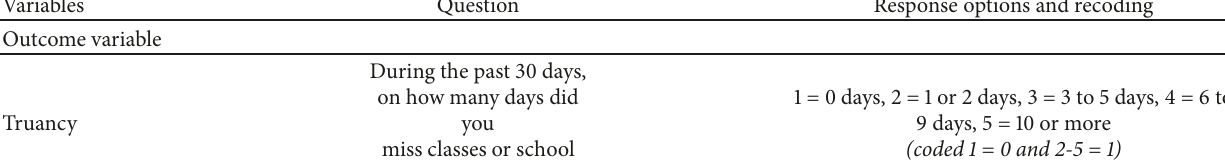
Table 1: Variable